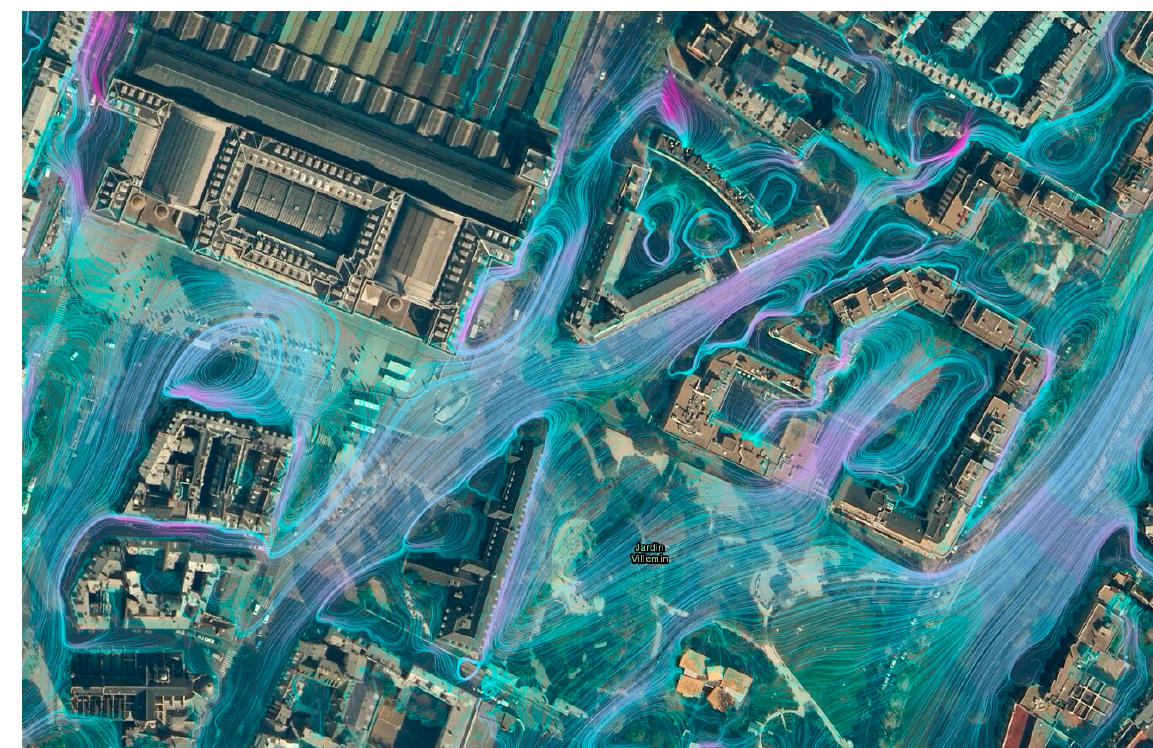
Figure 6. Closeup view of the flow streamlines computed in the streets south and east of the train station. The wind speed ranges from 0 m/s in cyan to 2 m/s in magenta.